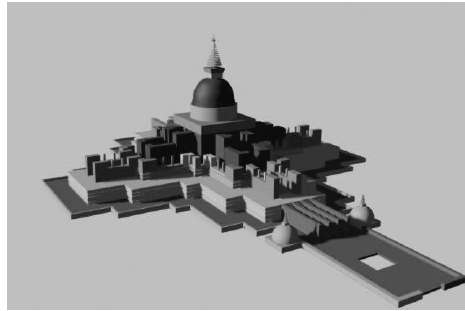
Fig.4: Reconstructed model based on the VKP that has the closest match with the existing ruins (Rashid,